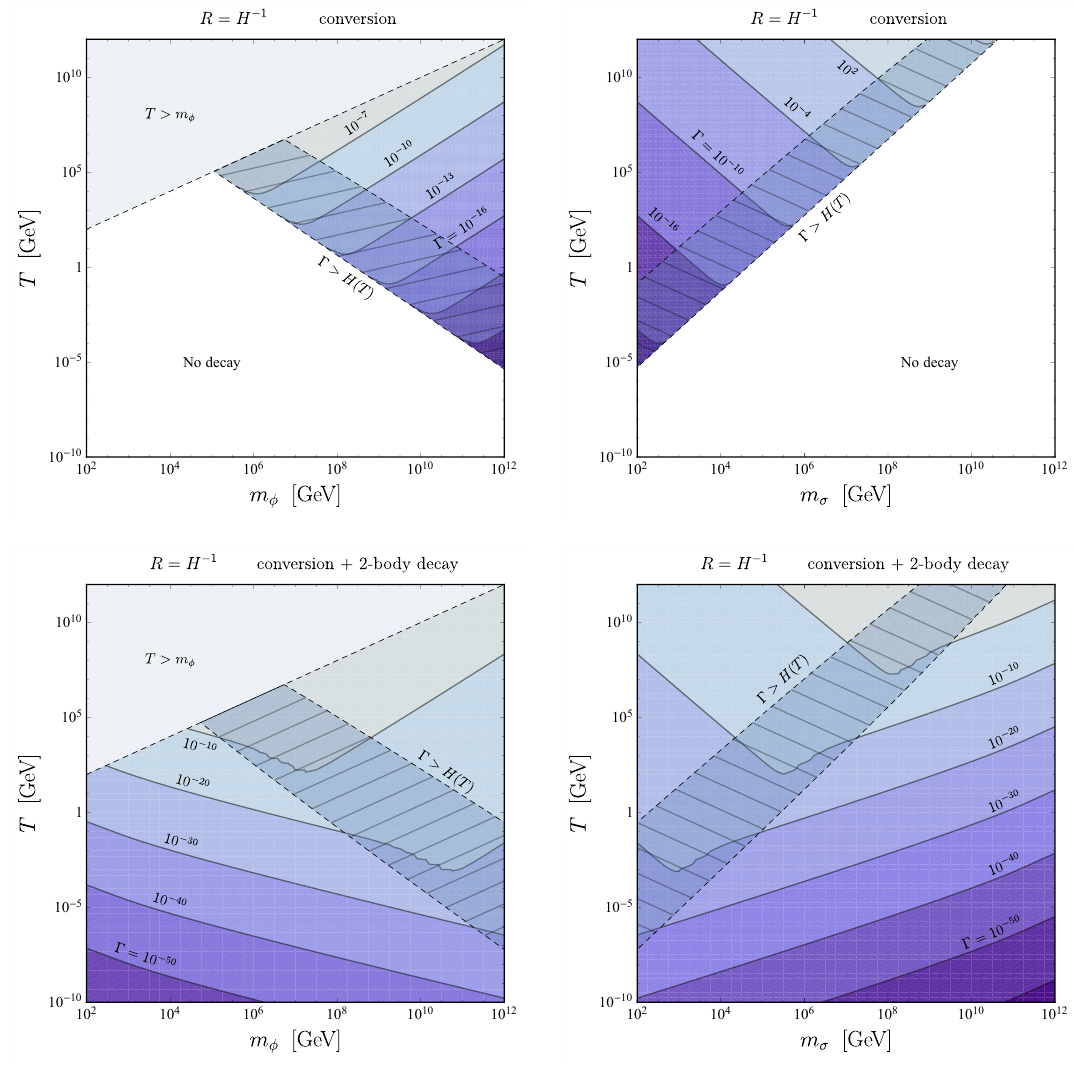
Figure 12 . The decay width caused by the string curve with R = H − 1 in the ( m φ , T ) -plane ( m = 10 2 GeV ) and in the ( m ) -plane ( m = 10 12 GeV ). The top (bottom) two panels correspond σ σ , T φ to the conversion process (the conversion and two-body decay processes). The values around the contours are given in GeV unit. In the white blank regions, the conversion process is kinematically forbidden. The gray regions with “ T > m ” is excluded since the string network does not φ